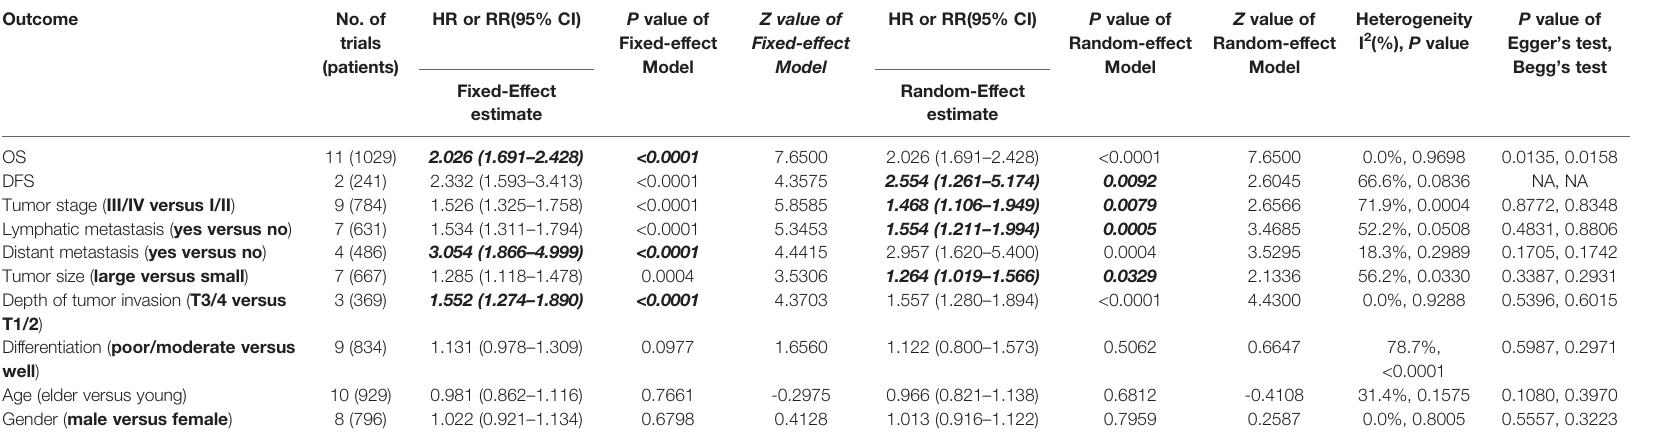
TABLE 3 | Meta-analysis of the effects of SOX2-OT overexpression on survival and clinical parameters.